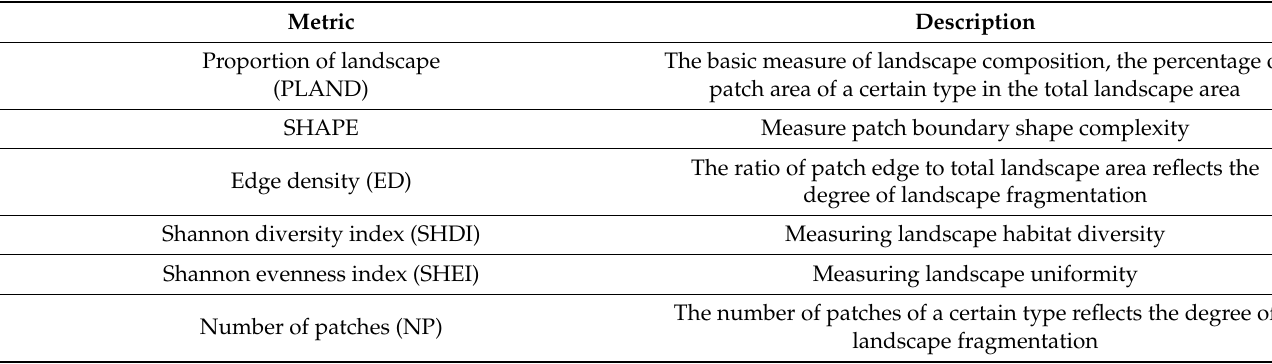
Table 2. Landscape pattern metrics and